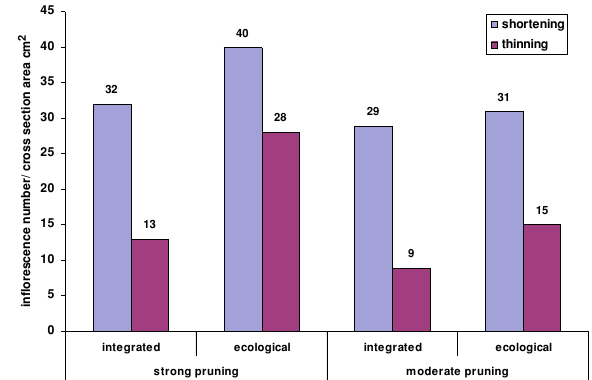
Figure 6. Effect of intensity and method of pruning on the blooming of the next year on ‘Idared’ apple trees grafted into M 26 roots in ecological as well as integrated growing system (Debrecen-Pallag 2009)